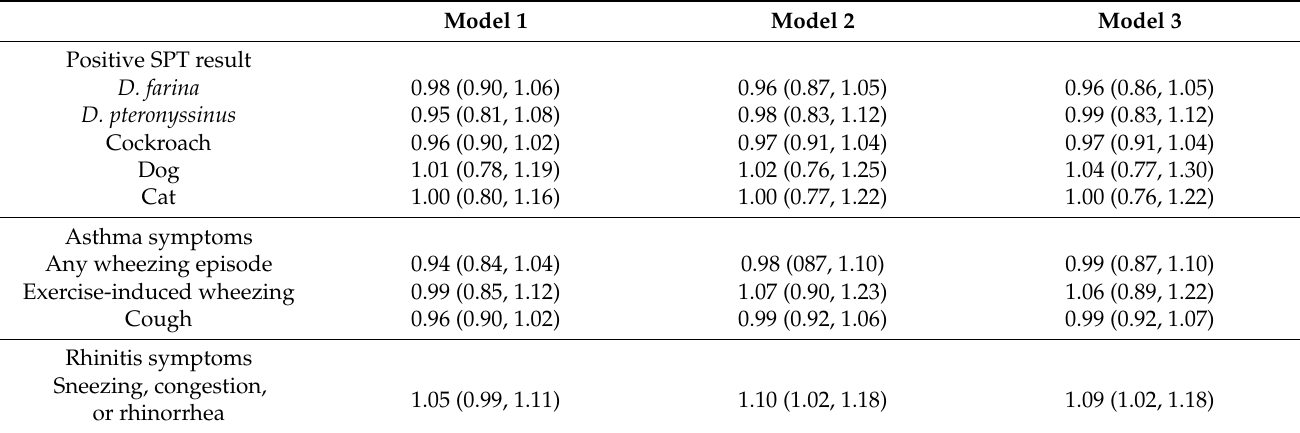
Table 5. Odds Ratios (OR) and 95% confidence intervals (CIs) of allergic outcomes associated with cumulative CO exposure